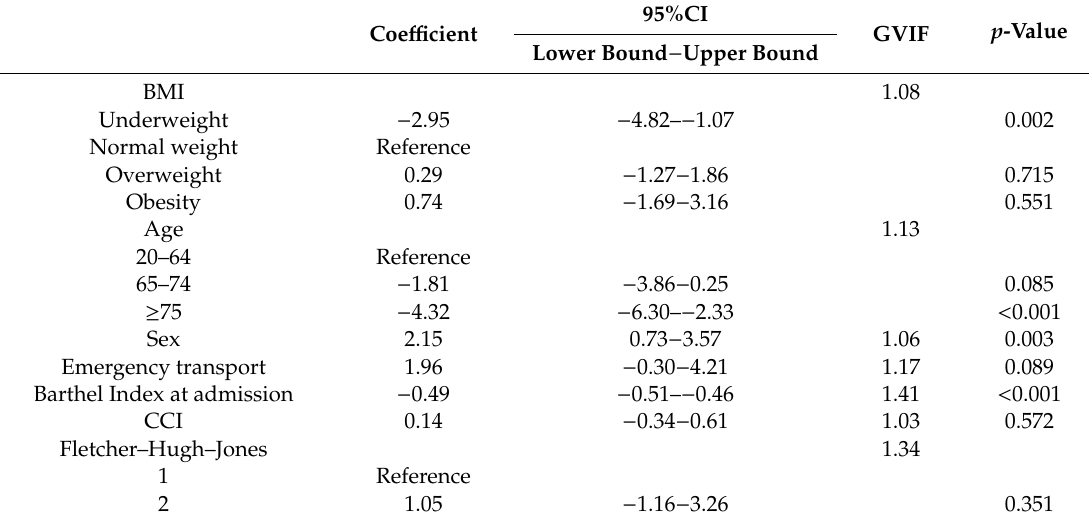
Table 3. Multiple regression analysis of change in Barthel Index during